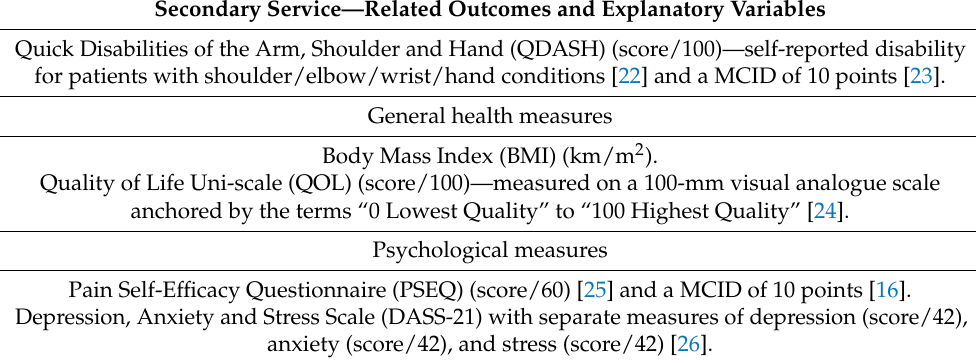
Depression, Anxiety and Stress Scale (DASS-21) with separate measures of depression (score/42), anxiety (score/42), and stress (score/42)